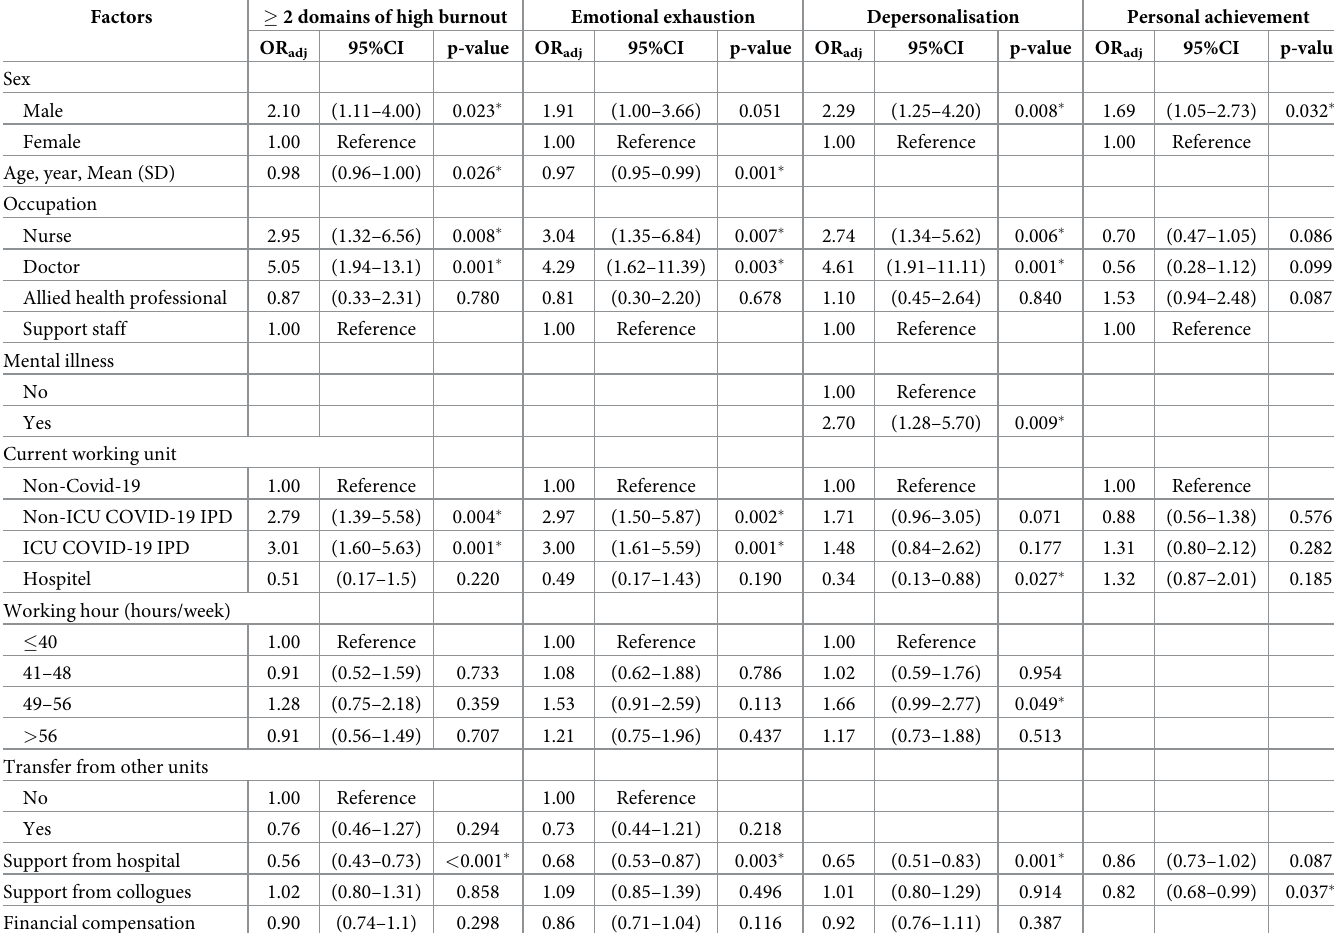
Table 3. Adjusted odds ratios from multivariable analysis of the associated factors of burnout among